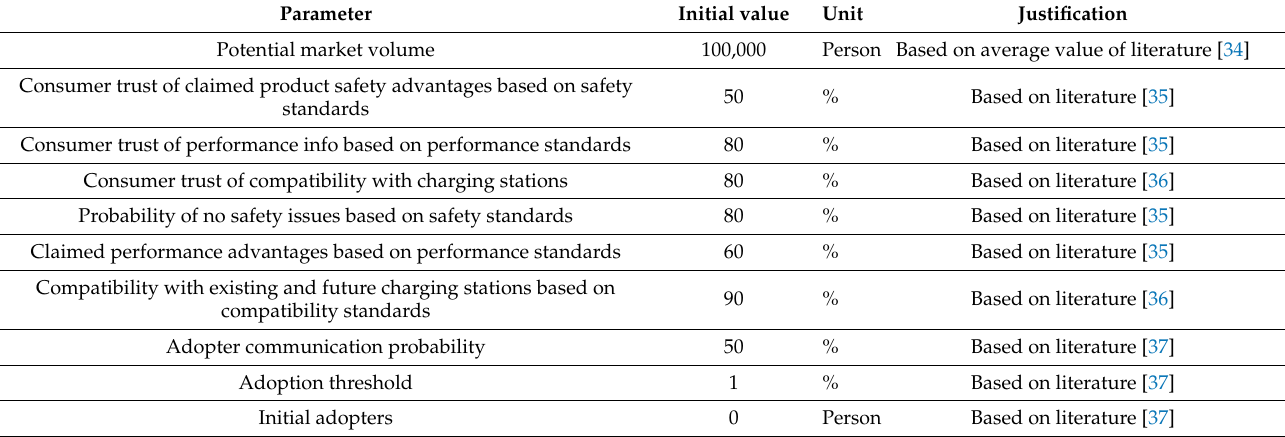
Table 2. The initial parameters of the SD